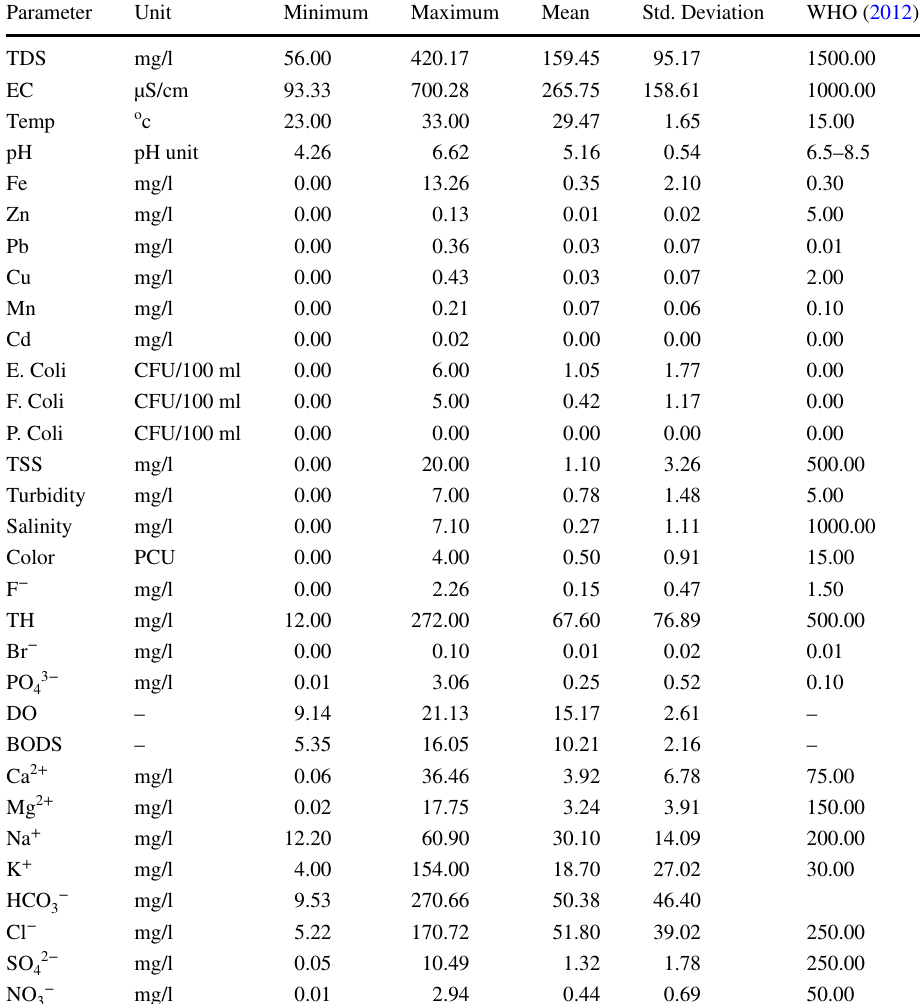
Table 1 Statistical summary of the groundwater